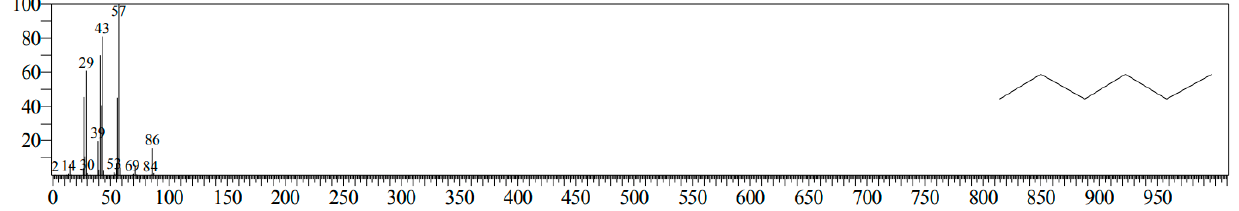
Figure 8. Comp Name: n-hexane, Run Time: 2.480, Mol Weight: 86.